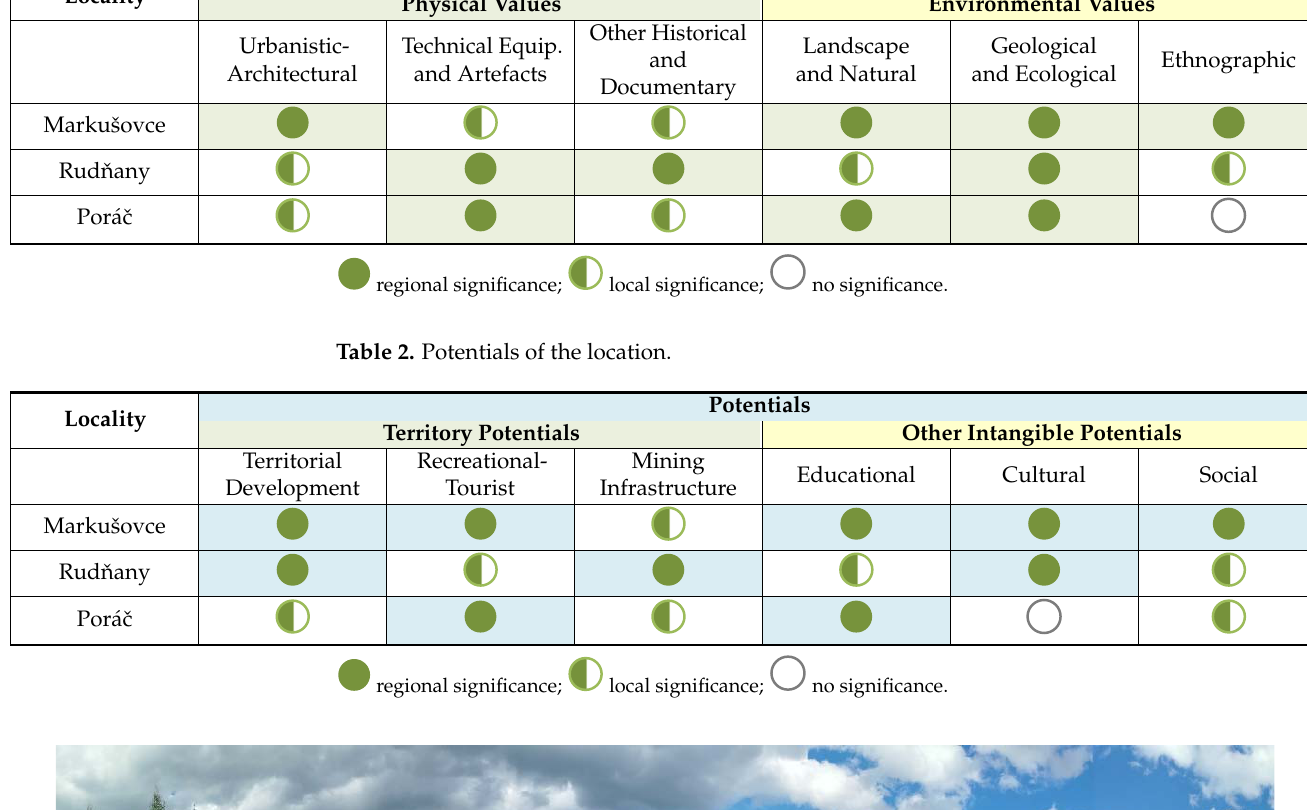
Table 2. Potentials of the location.